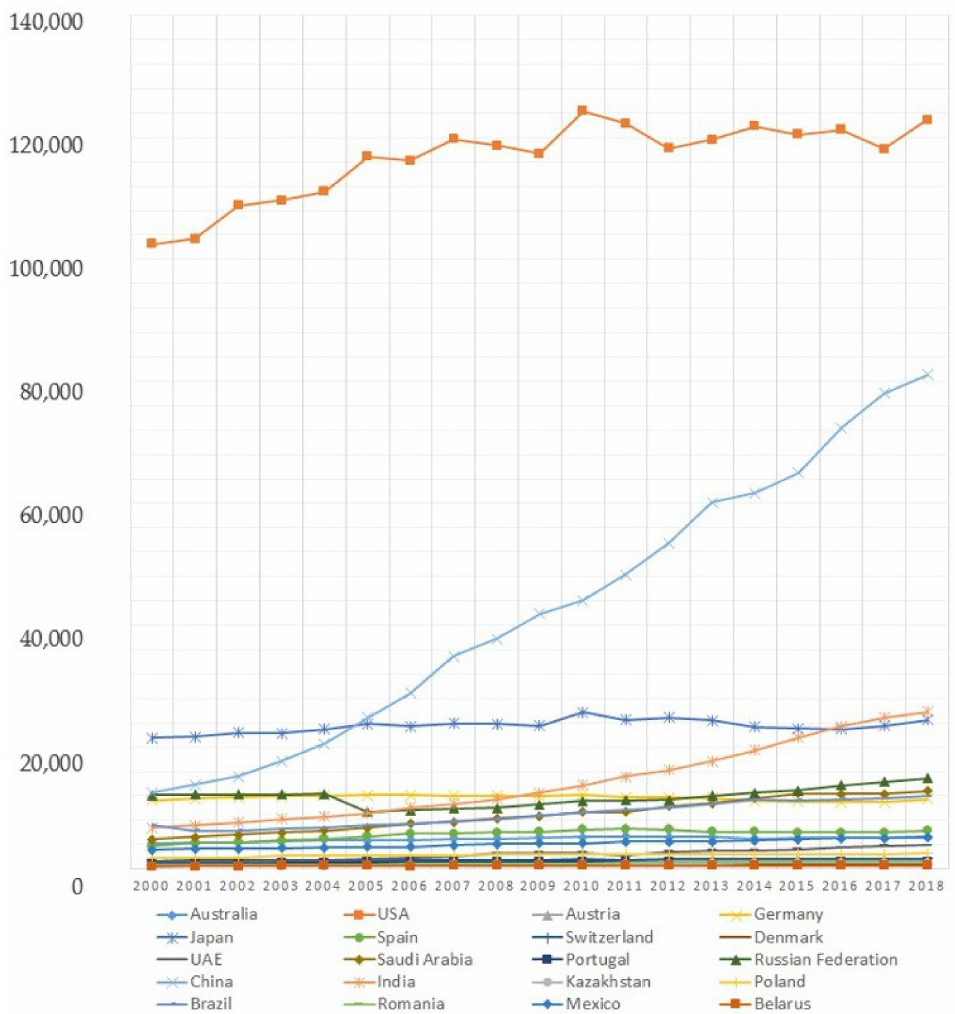
Figure 2. Final electricity consumption by households in the studied countries. Source: developed by the authors based on data